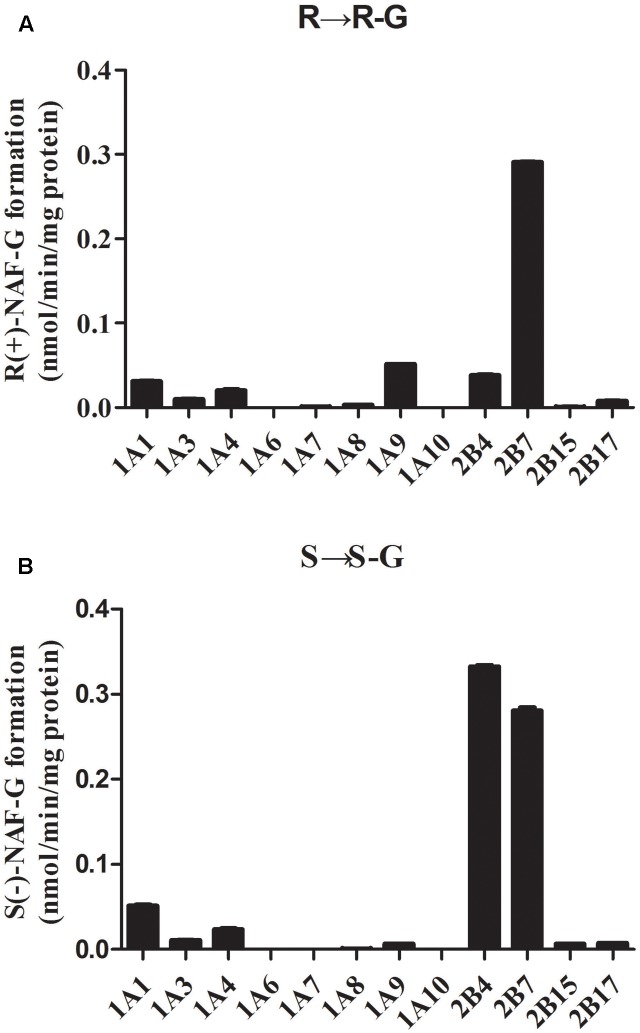
Screening of naftopidil enantiomers glucuronidation to form R(+)-NAF-G (A) and S(–)-NAF-G (B) with 12 recombinant human UGT enzymes (n = 3).